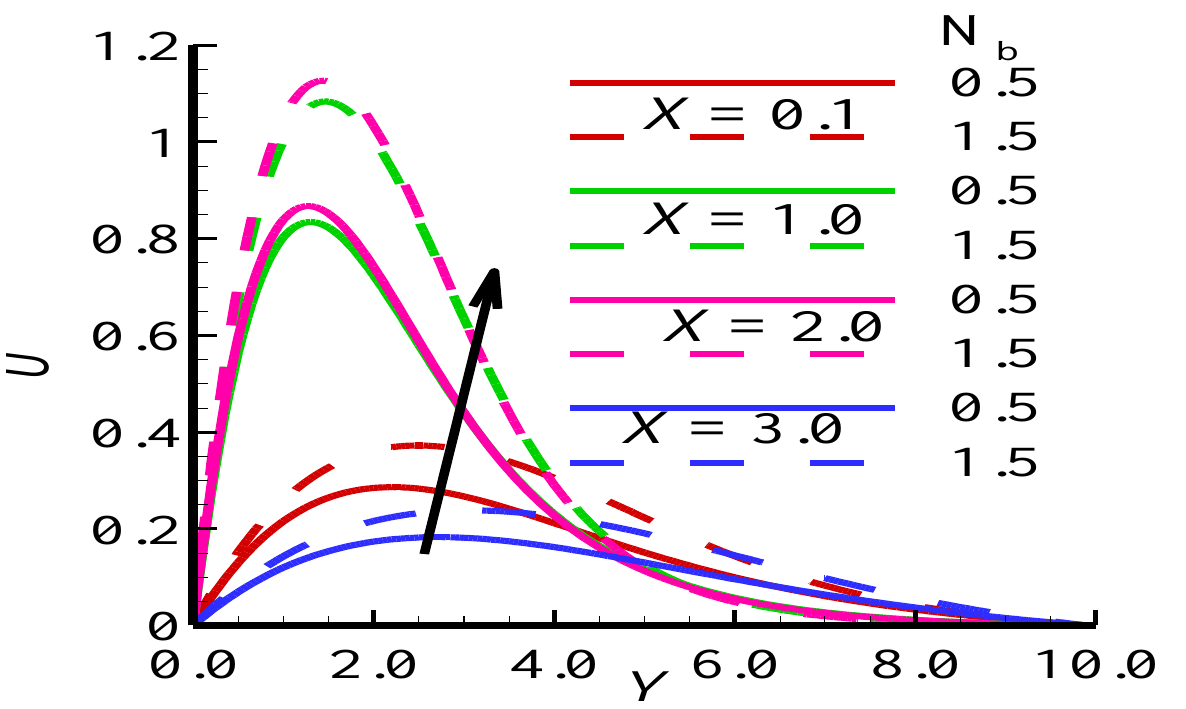
Figure 8. Outcomes of Brownian motion parameter N b on velocity distribution U when N = 0.5, Pr = 7.0, Nt = 1.5, and Sc = 10.0.